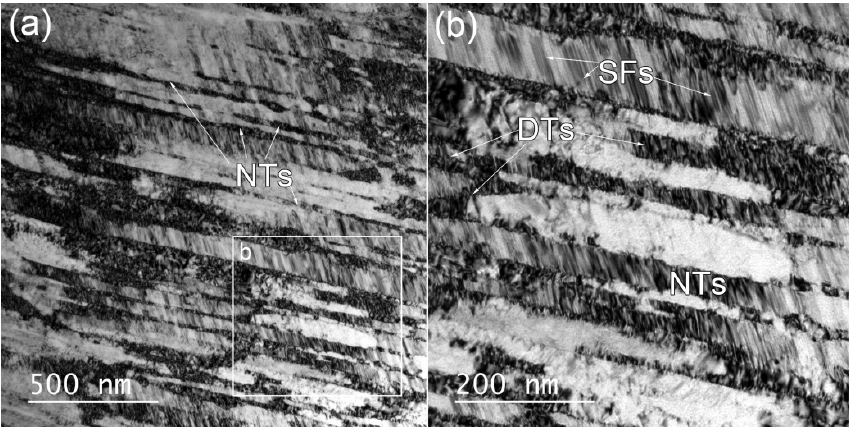
Figure 4. Transmission electron microscope (TEM) bright field (BF) images showing nanotwins (NTs): ( a ) dislocation tangles (DTs) and ( b ) stacking faults (SFs) in the surface of the sample twisted for 100 cycles at 10°/min.